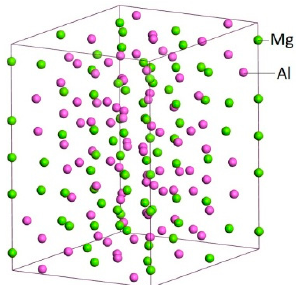
Figure 1. Crystal structure of Mg 23 Al 30 at ground state. Table 1. The calculated parameters of Mg 23 Al 30 under different pressures (pressure range: 1–8 GPa).